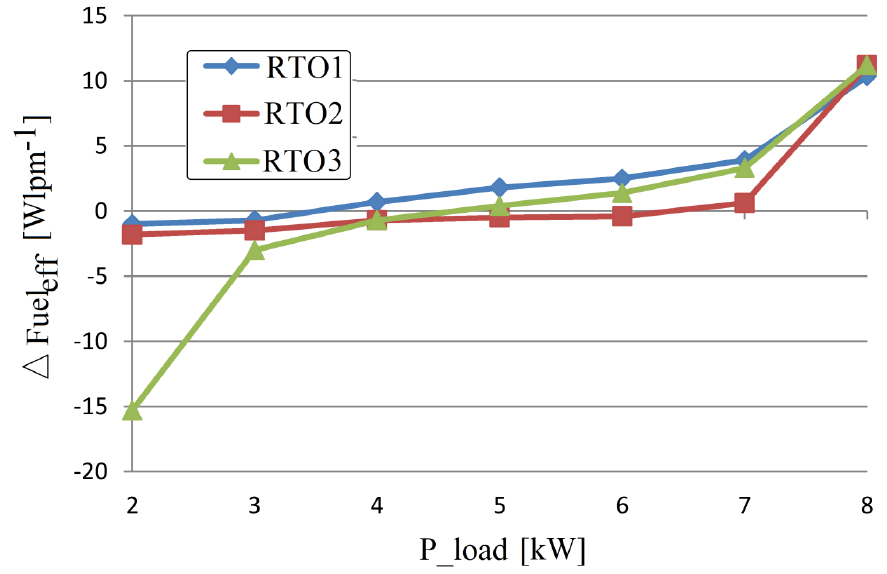
Figure 6. The deficiencies of the fuel efficiency for all RTO1, RTO2, and RTO3 strategies.